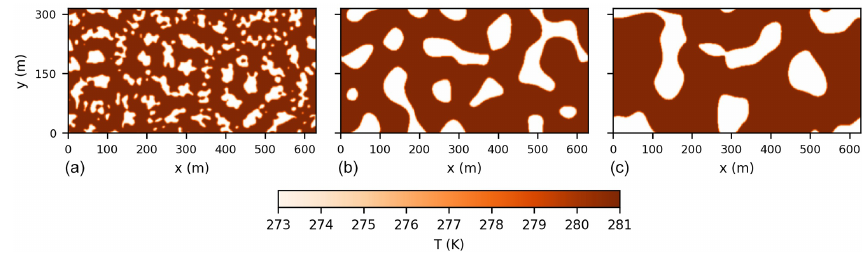
Figure 3. Generated realistic surface temperatures for the P15m and P15m-NB (a) , P30m (b) , and P60m (c) simulations. Table 3. Vertical shift correction (cm) applied in the individual height models per day for the upwind and downwind locations.